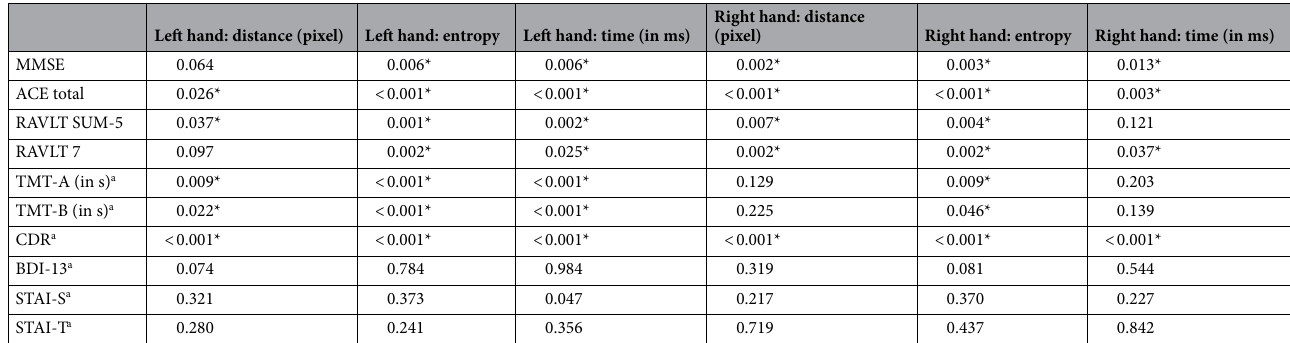
Table 4. Significance results (p-values) of correlation analysis across hand movement parameters and neuropsychological performance. Numerous significant correlations were presented between test scores measuring cognitive performance and motor actions, while there was no significant correlation among movements and neuropsychiatric properties including mood and anxiety measurements. *Indicates